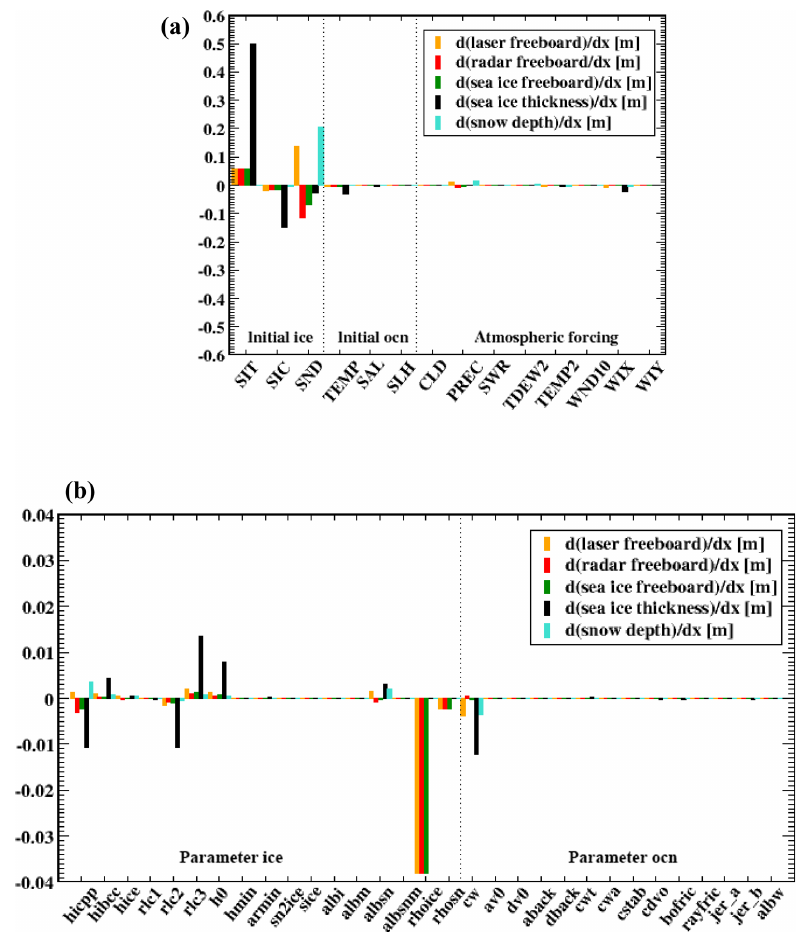
Figure 15. An excerpt of Fig. 14 of the observational Jacobian (top) in target region 6 (East Siberian Sea) and (bottom) for the model